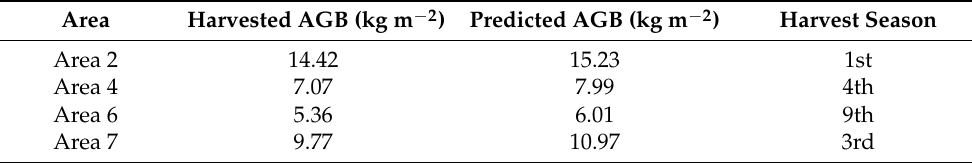
Table 6. Harvested and predicted AGB on test site areas 2, 4, 6, and 7.